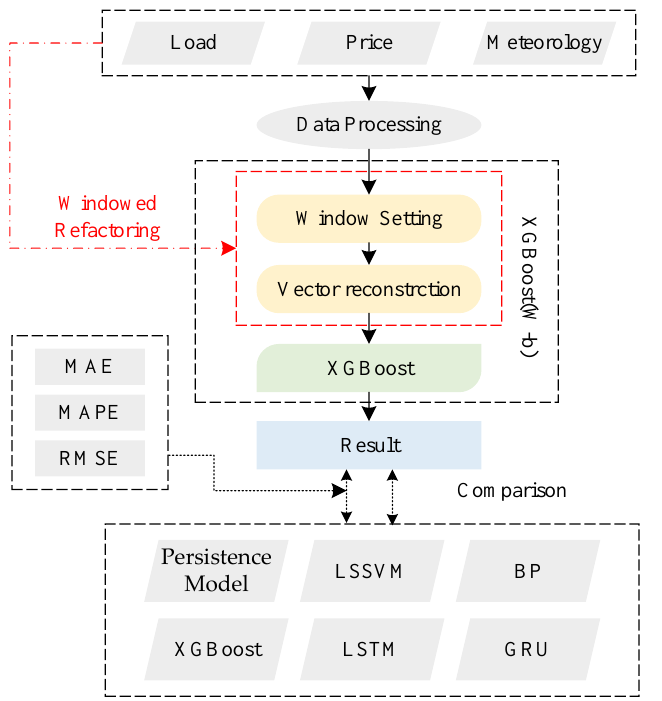
Figure 2. Ultra-short-term power load forecasting model considering real-time electricity price.